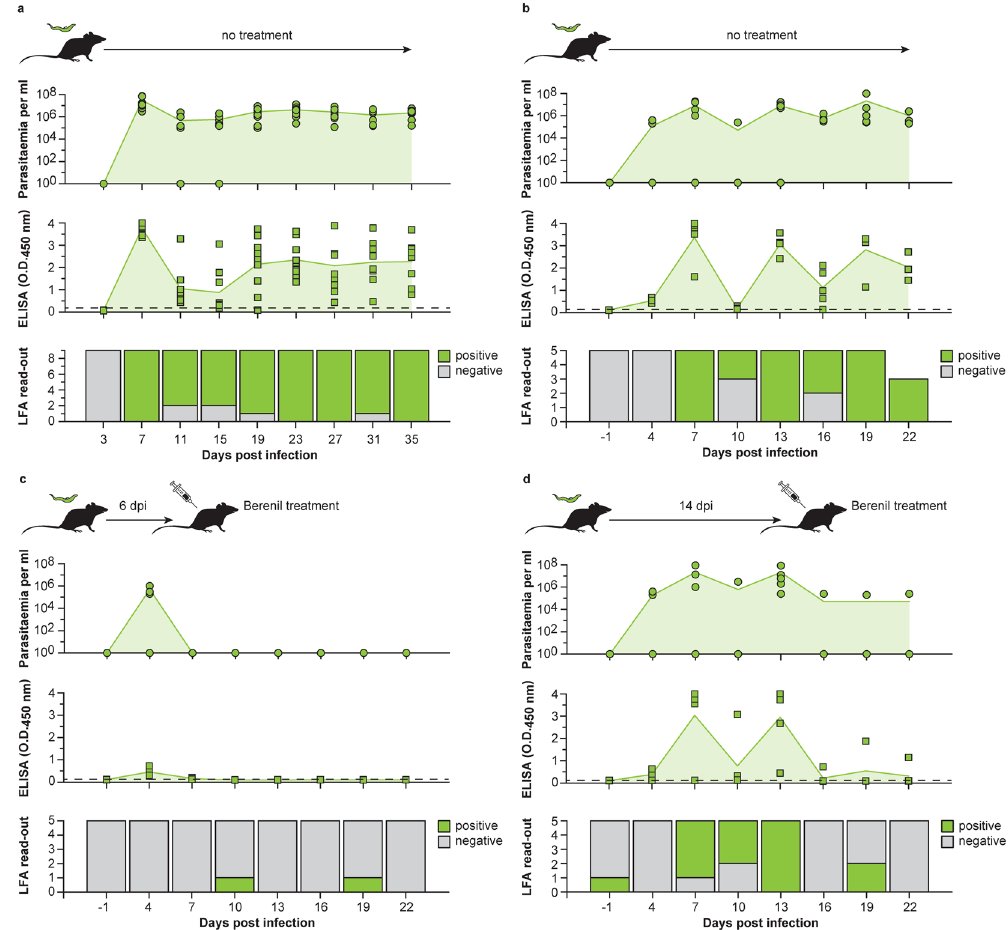
Figure 6. The Nb44-Nb44/Nb42 ELISA and Nb44/Nb42 LFA can be used as test-of-cure tools during experimental T . congolense infections in mice. ( a ) The detection of target antigen via the Nb44-Nb44/Nb42 ELISA and Nb44/Nb42 LFA correlate well with parasitaemia. The top panel displays the parasitaemia as determined by microscopy monitored over the course of the infection in C57BL6/C mice infected with T . congolense Tc13 (n = 9). The middle panel shows the antigenaemia observed by the Nb44-Nb44/Nb42 ELISA. The mean values for parasitaemia and antigenaemia are represented by the green line with light green fill. The dashed line displays the ELISA detection cut-off value. The bottom panel shows the results of the LFA read-outs on the infected mice. ( b–d ) C57Bl6/C mice infected with T . congolense Tc13 were divided into three groups (Group 1 (n = 5), left untreated; Group 2 (n = 5), treated with Berenil at 6 dpi; Group 3 (n = 5), treated with Berenil at 14 dpi) and antigenaemia and parasitaemia were followed over time. The results for Group 1, Group 2, and Group 3 are shown in panels (b–d), respectively. The panels and colour codes are the same as for panel (a).